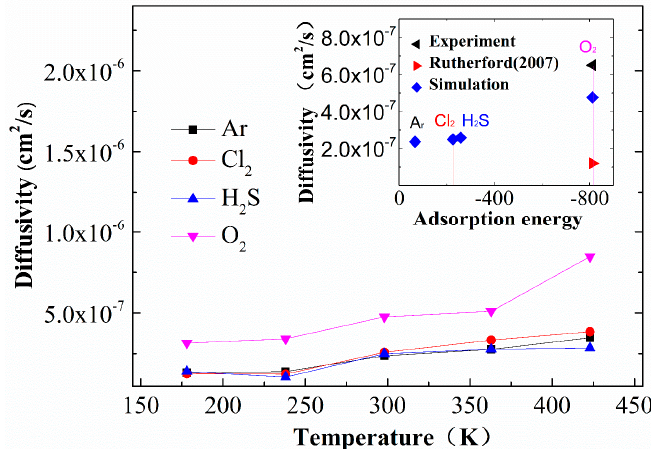
Figure 6. The diffusion coefficients of oxygen, hydrogen sulfide, argon, and chlorine at different temperatures are represented by colored curves. The inset shows the comparison between the results of this study’s simulation of oxygen and those reported by Rutherford [18].